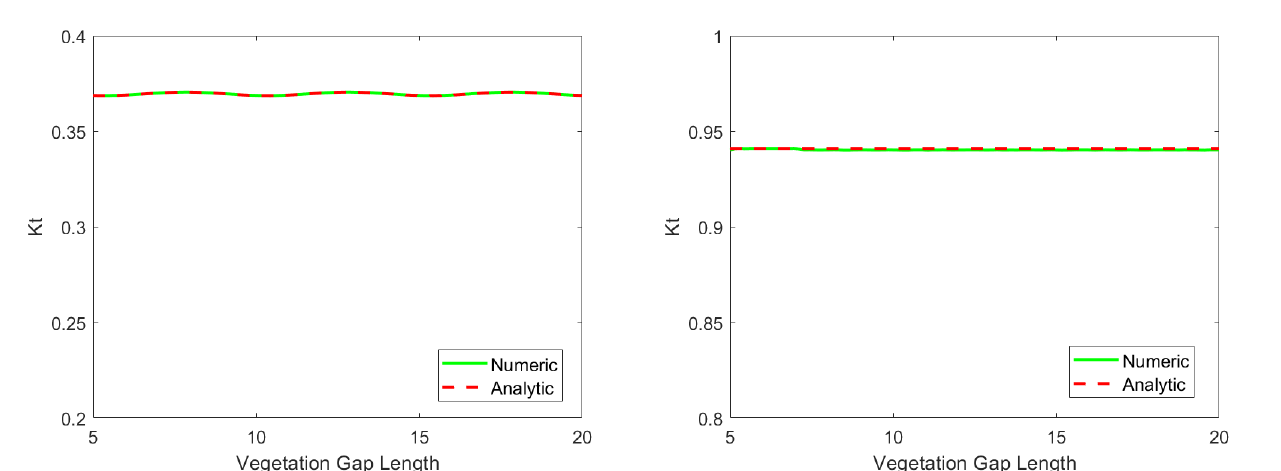
Figure 8. Numerical and Analytical Comparison of transmission coefficient K t and Vegetation Distance Relation with ( left ) Friction Coefficient, c f = 0.32 ( right ) Diffusion Coefficient, c D =